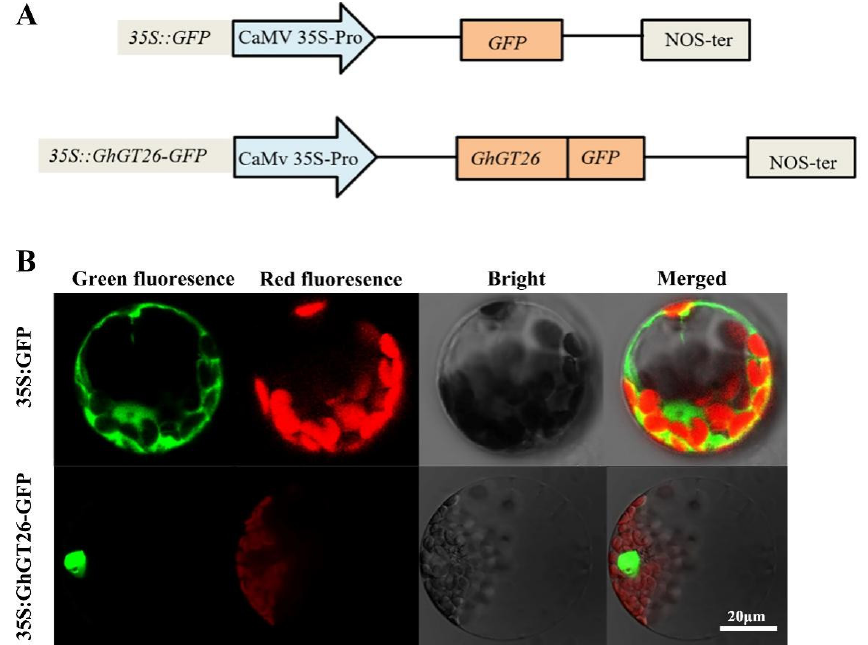
Figure 6. Subcellular localization analysis of the GhGT26 protein in Arabidopsis protoplasts. ( A ) Schematic illustration of the fusion vector (35S::GhGT26-GFP) and control construct (35S::GFP). ( B ) Transient expression of 35S::GhGT26-GFP fusion and the 35S::GFP constructs in the Arabidopsis protoplasts. The green fluorescence indicates the location of the GFP control or GFP fusion proteins. Red fluorescence indicates the positions of chloroplasts. Images were captured by a laser canning confocal microscope using the following wavelengths: GFP (excitation 488 nm; emission 509 nm), and chlorophyll auto fluorescence (excitation 448 nm; emission 647 nm). Bars = 20 μm.